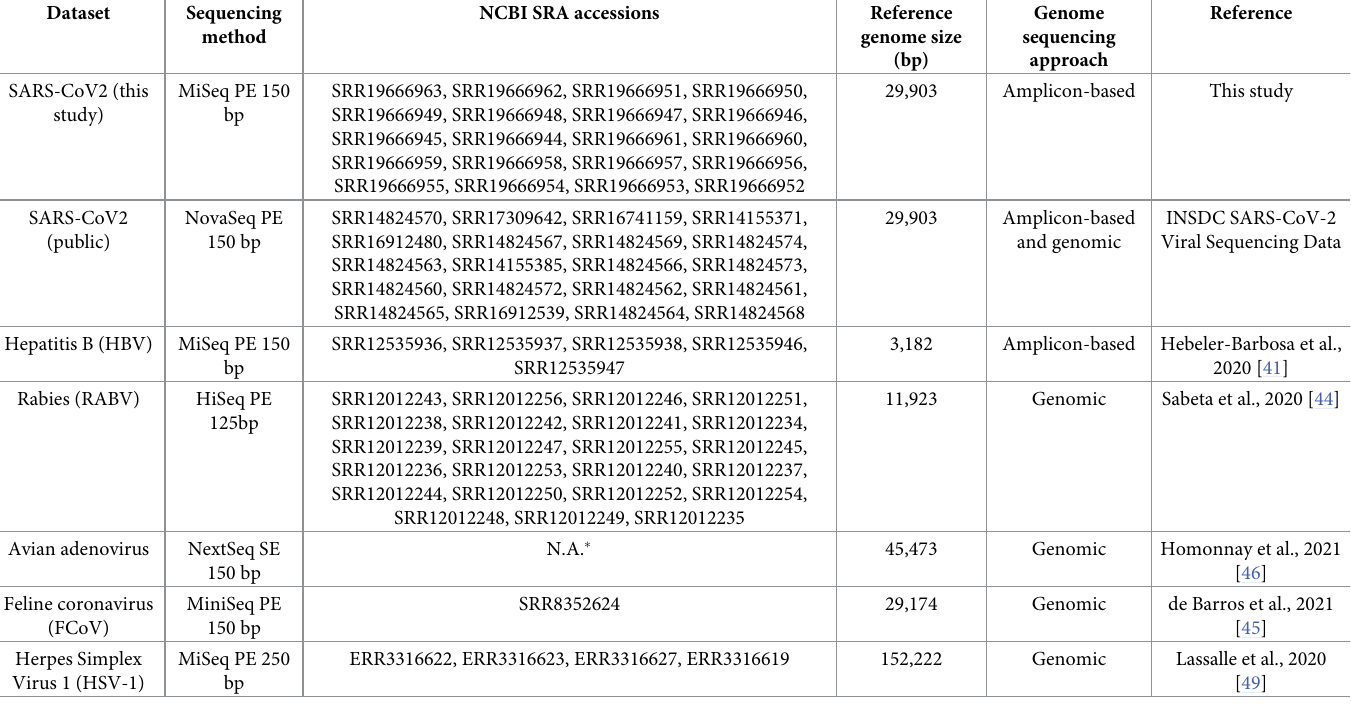
Table 1. Summary of datasets used in this